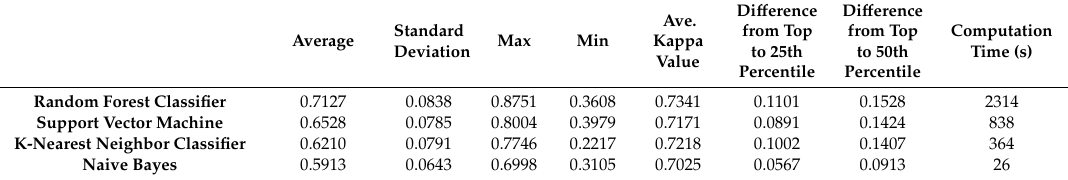
Table 5. Summary of classification accuracy of di ff erent methodologies averaged over all classification